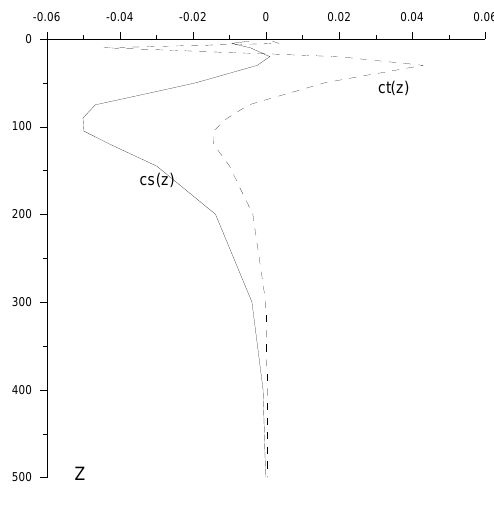
Fig. 1. Normalized weight coefficients for extrapolation of temper- Figure 1 Normalized weight coefficients for extrapolation of temperature and salinity with depth. ature and salinity with